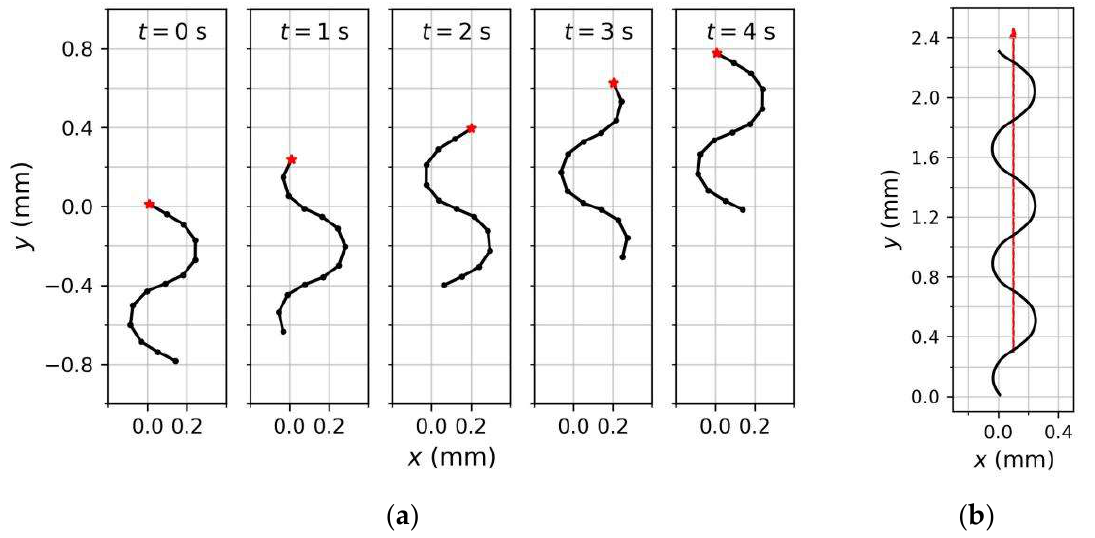
Figure 9. Model shapes in one cycle ( a ); and the forward locomotion trajectory ( b ); under the rhythmic pattern shown in Figure 8. The red line represents the translation direction.